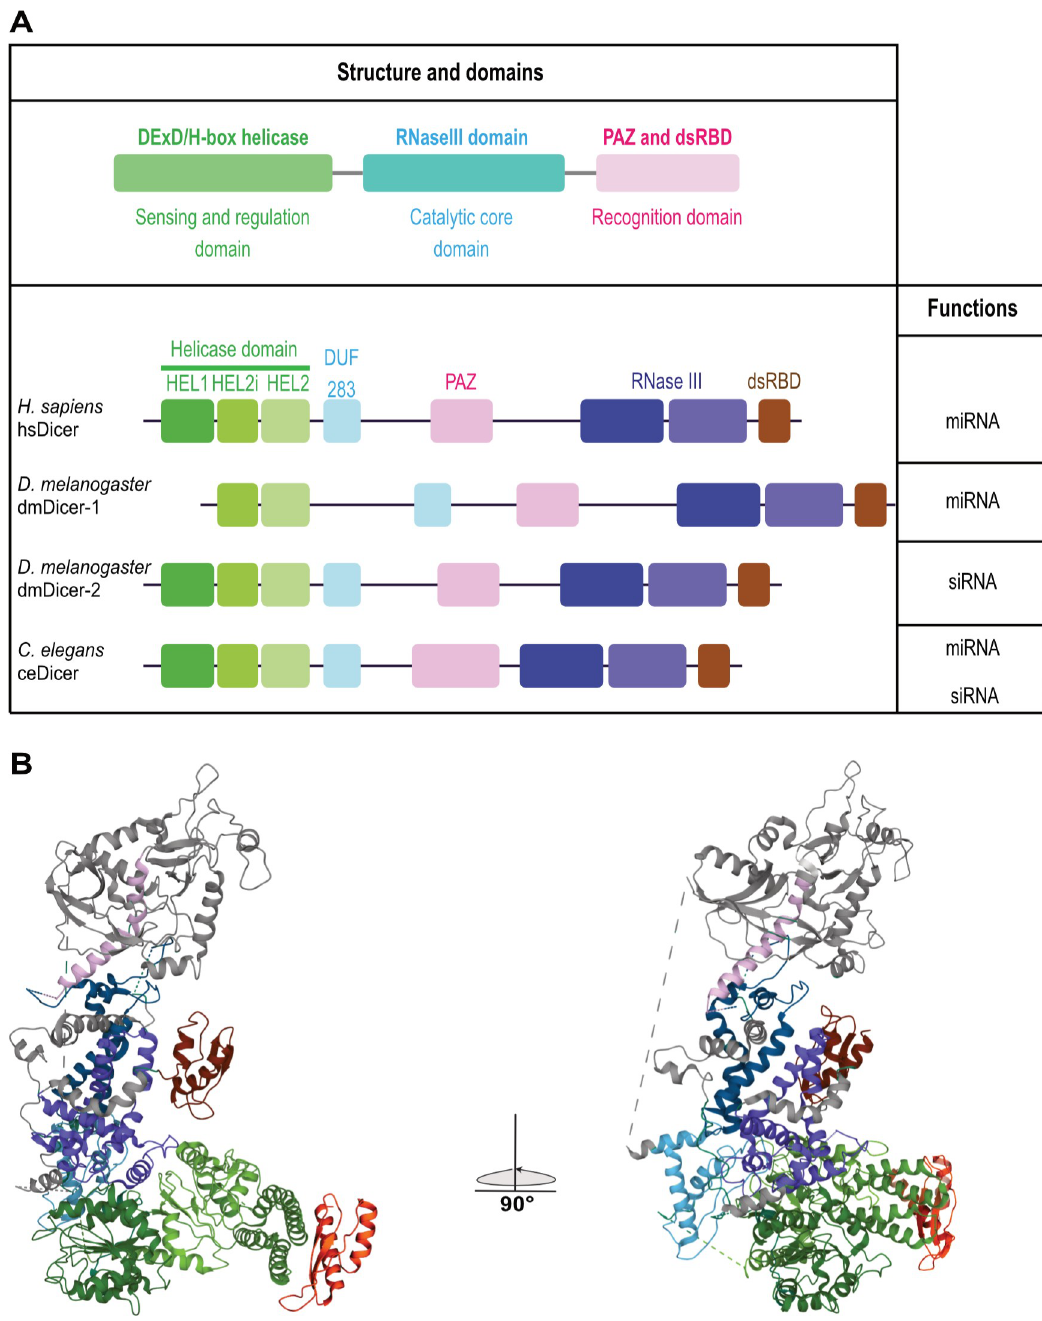
Fig 1. Domains organization and functions of Dicer proteins in metazoans. (A) Dicer carries a DExD/H-box helicase, which is divided into 3 subdomains: HEL1, HEL2i, and HEL2. The domain of unknown function (DUF283) is regulating pre-miRNA binding and the PAZ domain is involved in the recognition of the 3 0 -overhanged extremities. The catalytic core is composed of 2 RNase III domains that each processes one strand of the duplex. Finally, the terminal dsRBD is involved in the binding of the dsRNA minor groove. (B) Position of the different domains in the tridimensional structure of human Dicer in complex with TRBP determined by cryo-EM [22]. The color code used for the domains is the same as in A. TRBP is in orange (adapted from PDB structure n˚5ZAK). cryo-EM, cryo-electron microscopy; dsRBD, dsRNA-binding domain; miRNA, microRNA; PAZ, Piwi– Argonaute–Zwille; siRNA, small interfering RNA; TRBP, TAR RNA-binding protein.